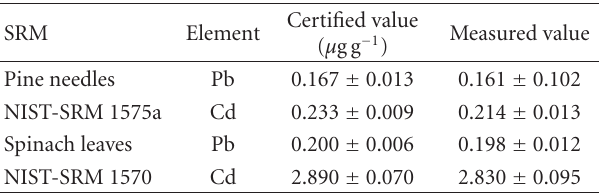
Table 3: The weight of 20 cigarettes (g) concentration of Pb in µ gg − 1 (dry weight) and average estimated amount of Pb passed